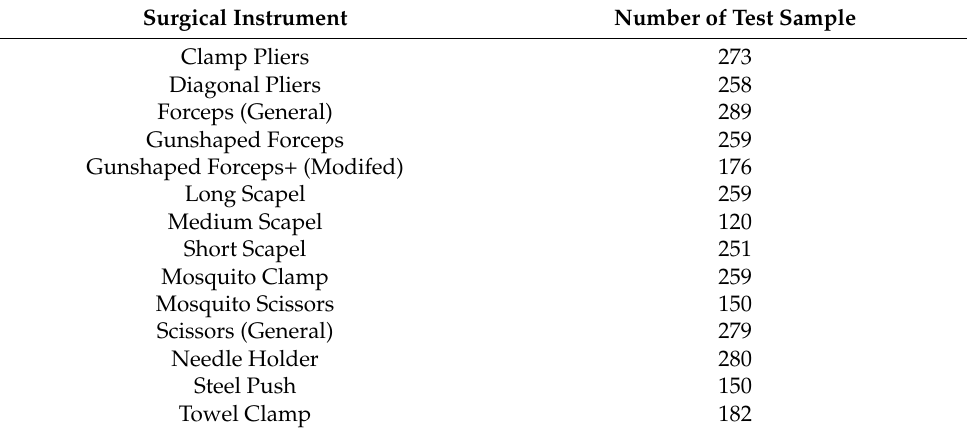
Table 1. The number of test samples for each type of the 14 surgical